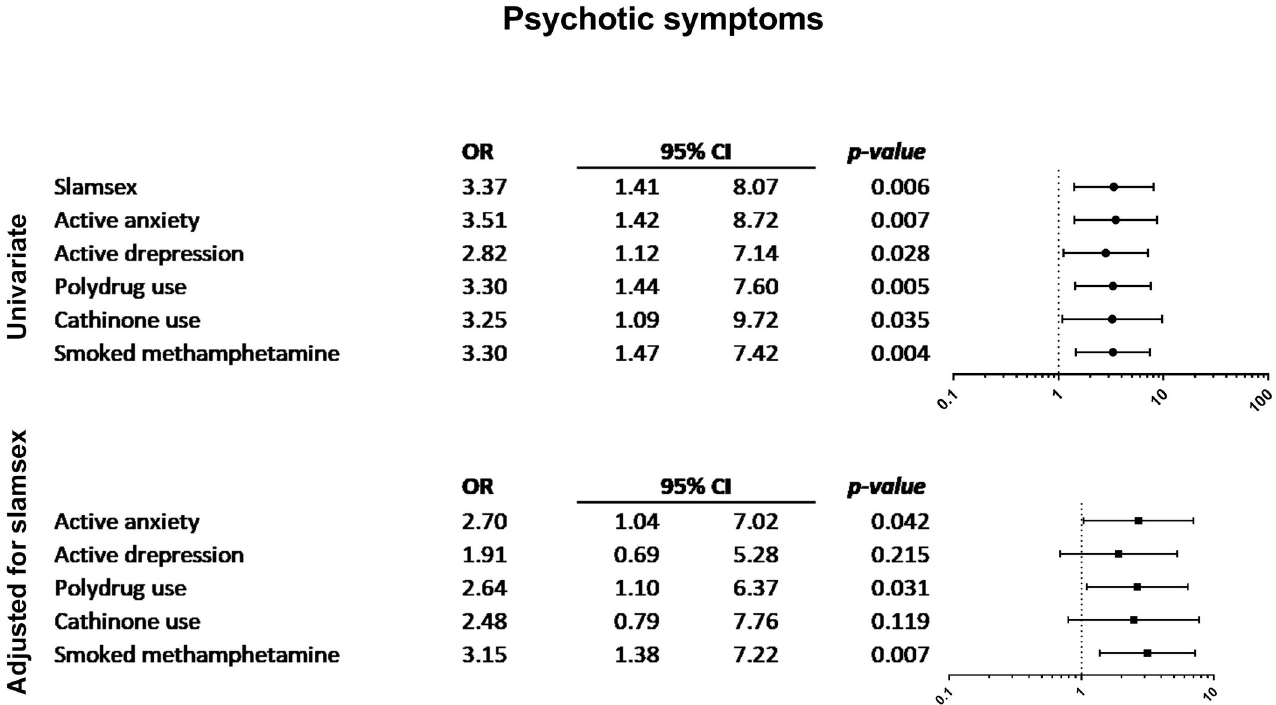
Fig 3. Association between current self-reported psychiatric diagnosis and psychotic symptoms. https://doi.org/10.1371/journal.pone.0220272.g003 PLOS ONE | https://doi.org/10.1371/journal.pone.0220272 December4, 2019 8 /